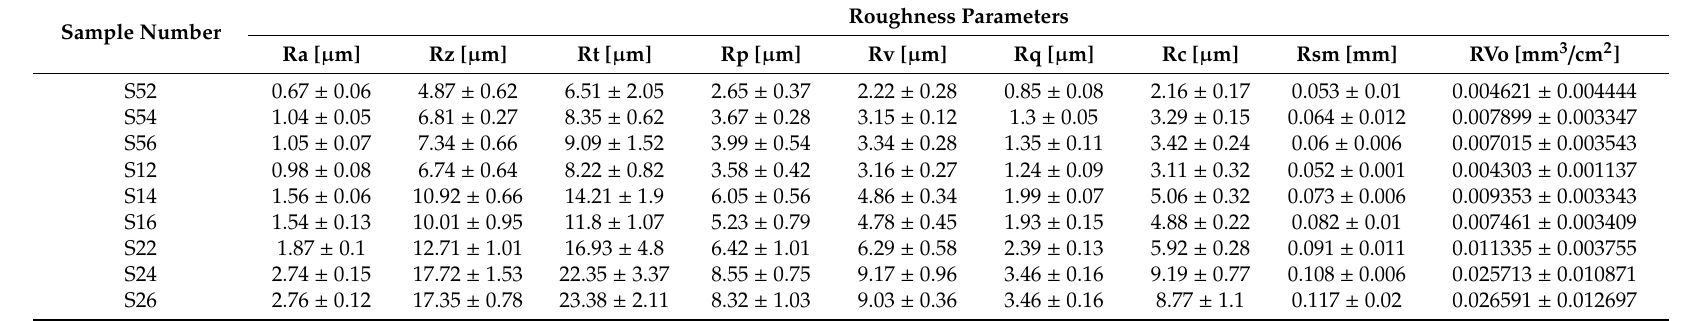
Table 4. Surface roughness results.